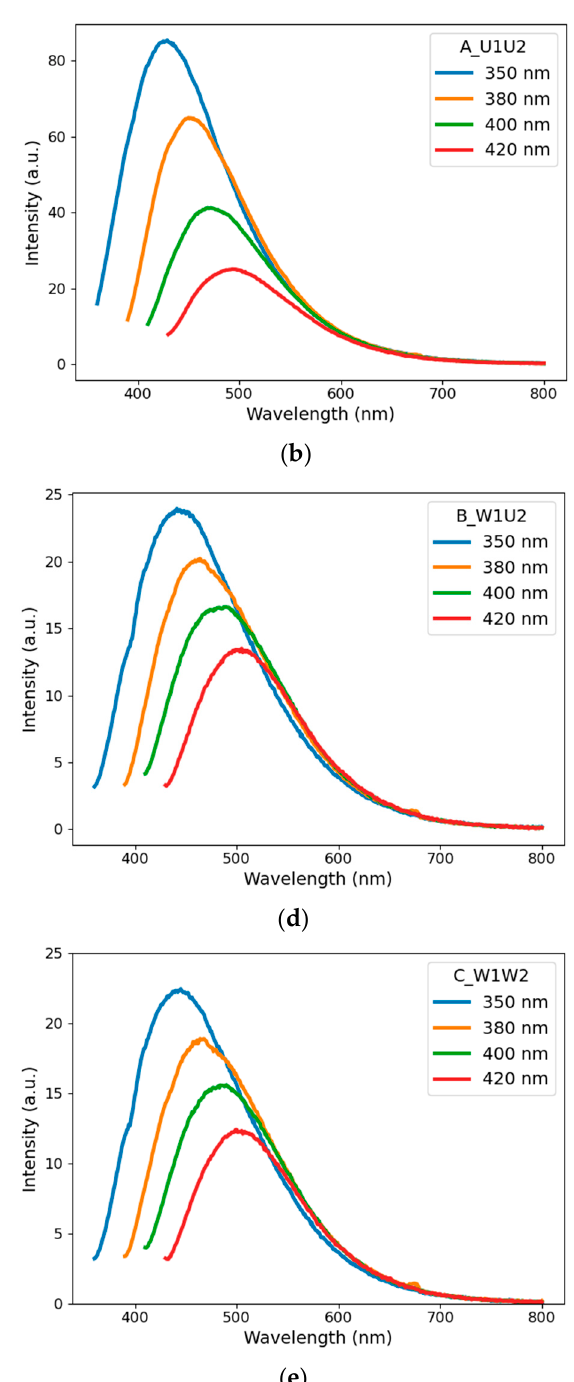
Figure 3. Photoluminescence spectra of carbon nanostructures obtained via Approaches ( a ) A_U1, ( b ) A_U1U2, ( c ) B_W1, ( d ) B_W1U2, and ( e ) C_W1W2. Excitation wavelengths ranged from 350 to 420 nm.